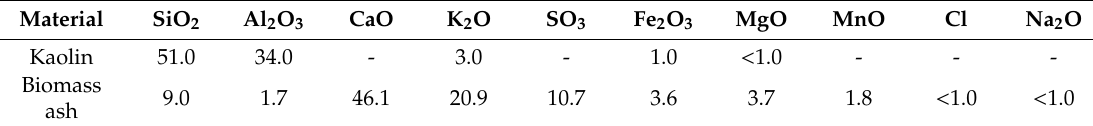
Figure 2. SEM images of ( a ) metakaolin and ( b ) biomass ash.